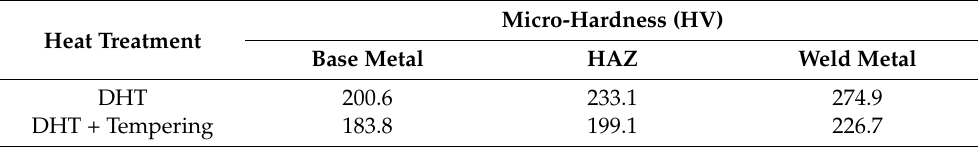
Table 4. Micro-hardness of subzones in welded joints with different heat